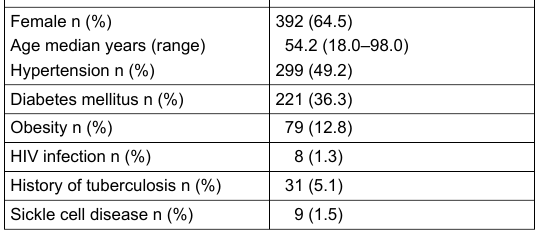
Table 2: Prevalence of CKD (population n = 608 [100%]).